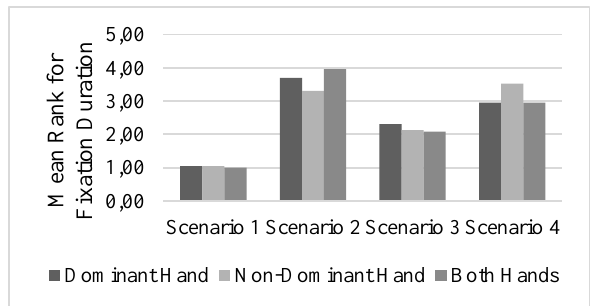
Figure 6. Fixation Duration Differences Among Scenarios Wilcoxon signed-rank tests was conducted for under- standing the difficulty levels between scenarios under dominant-hand, non-dominant hand and both hands condi- tions with a Bonferroni correction (p < 0.017). The mean and standard deviation values for each scenario under dominant hand, non-dominant hand and both hands condi- tions are given at Table 5.